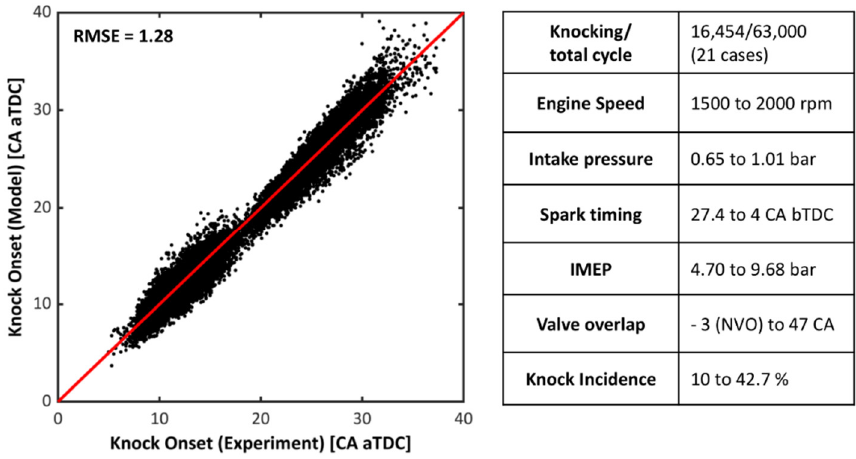
Figure 12. Knock prediction model with individual cycle data